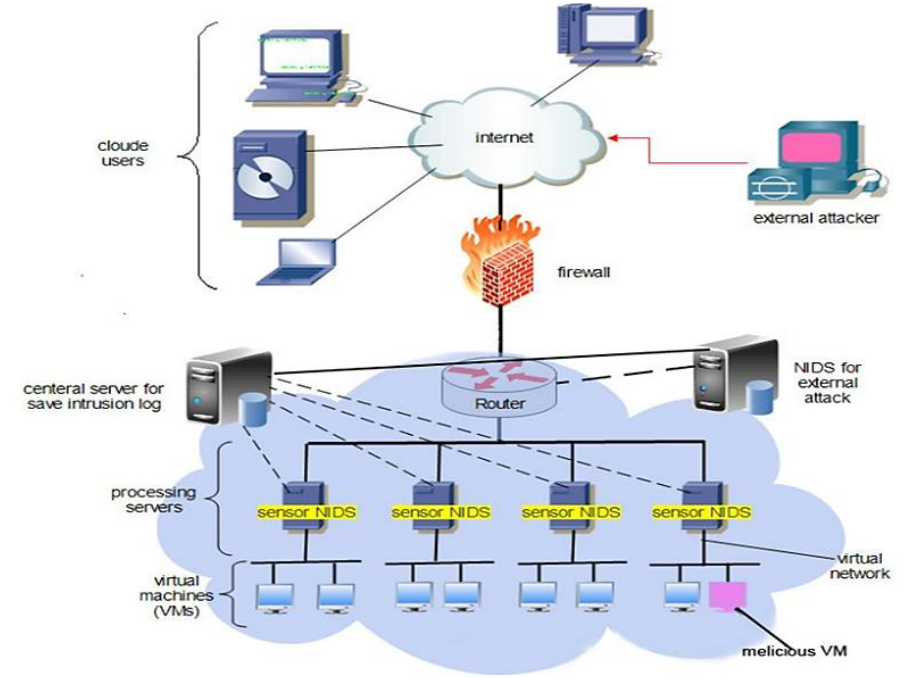
Figure 1. Positioning of the proposed attacks and intrusion detection system in a cloud network.